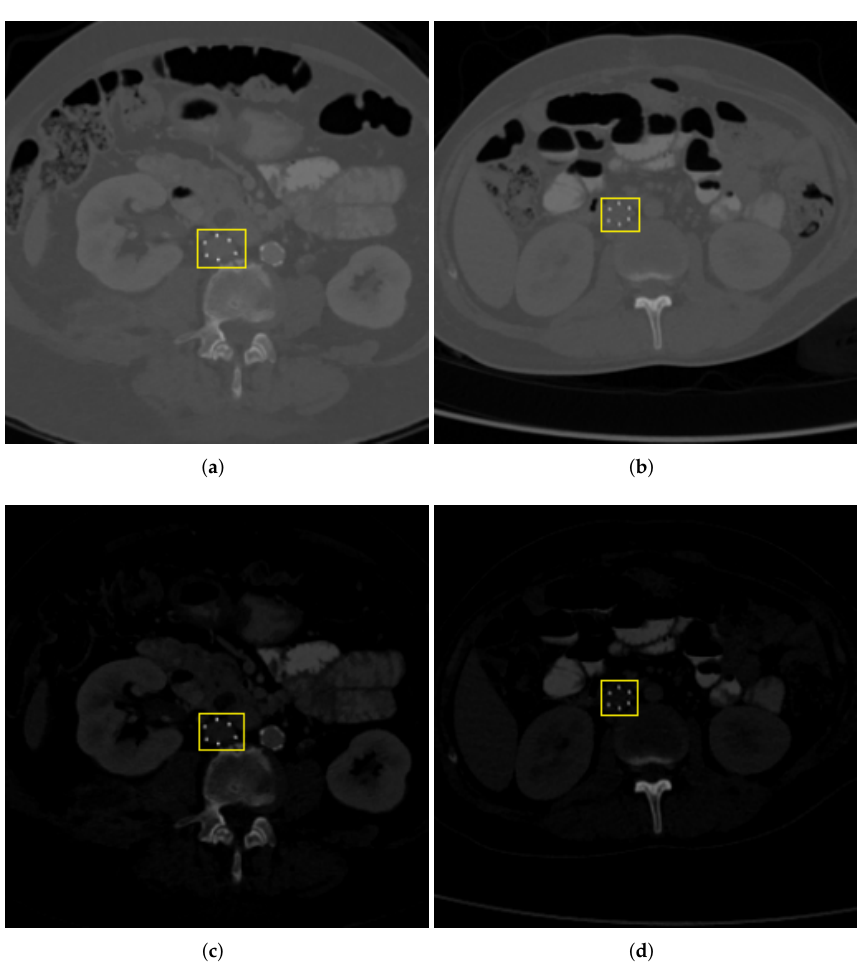
Figure 4. Example of CT scan slices along the axial plane with IVCF. Top row ( a , b ) are without application of intensity adjustment (Soft Normalization). Scans ( c , d ) have HU values adjusted by setting minimum as 1 and maximum as 2500 (Hard